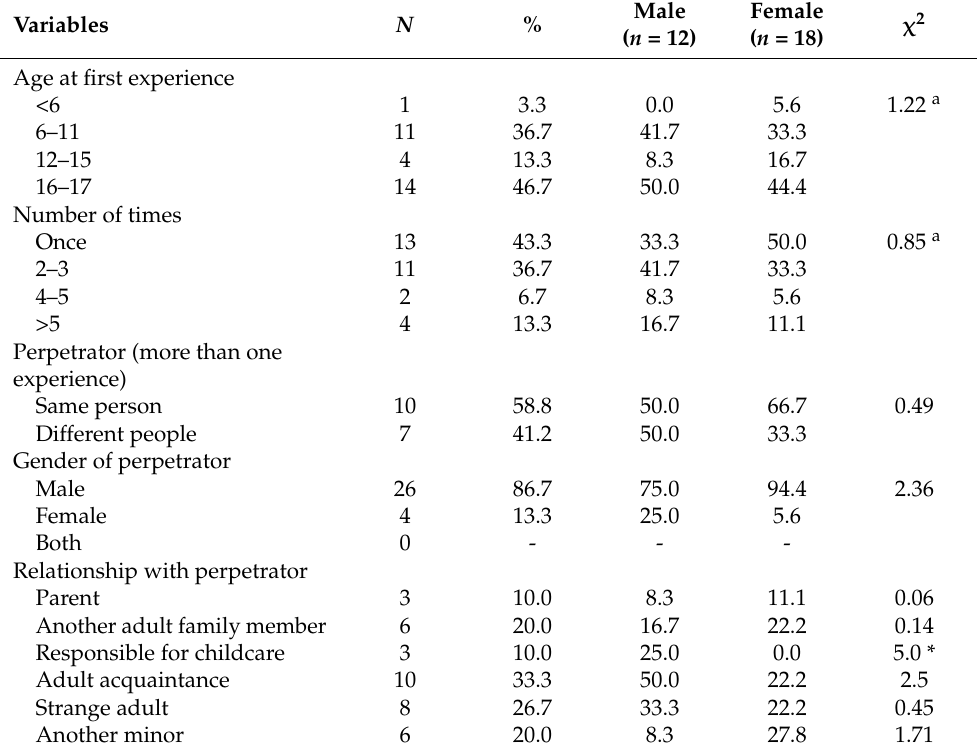
Table 6. Percentage of victims’ age at the first experience and perpetrator’s characteristics as a function of gender for “somebody forced me to perform a sexual act involving penetration”. Variables N %